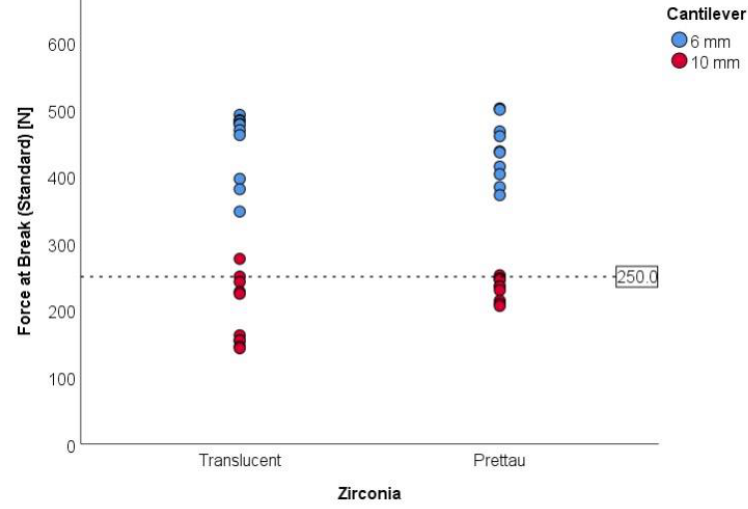
Figure 7. Force at break (standard) (N) for all components included in the study and the considered limits